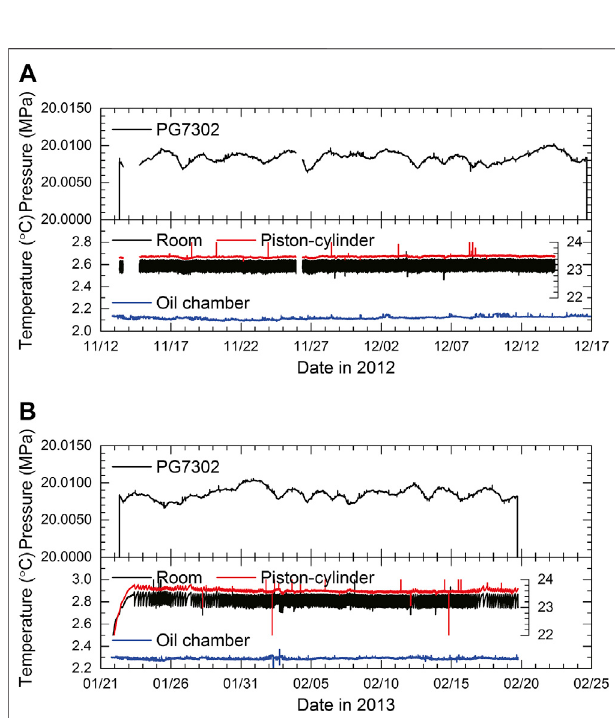
in 2012. (B) The experiment in 2013 is presented in the same form as (A)